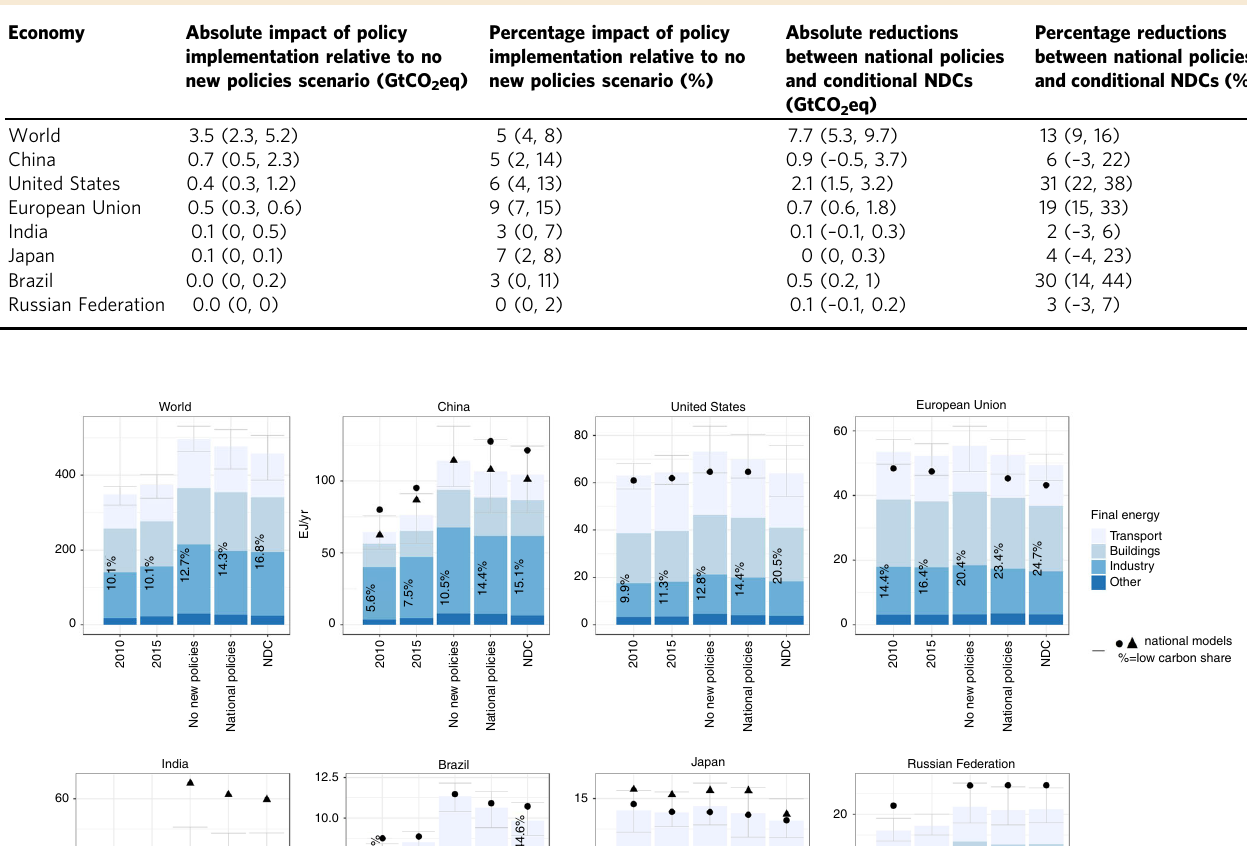
Table 2 Absolute (GtCO 2 eq) and percentage impact of policy implementation relative to no new policies scenario, and implementation gap with NDC scenario for the world, China, United States, India, EU, Japan, Brazil and Russian Federation (median value and 10 – 90% in brackets).